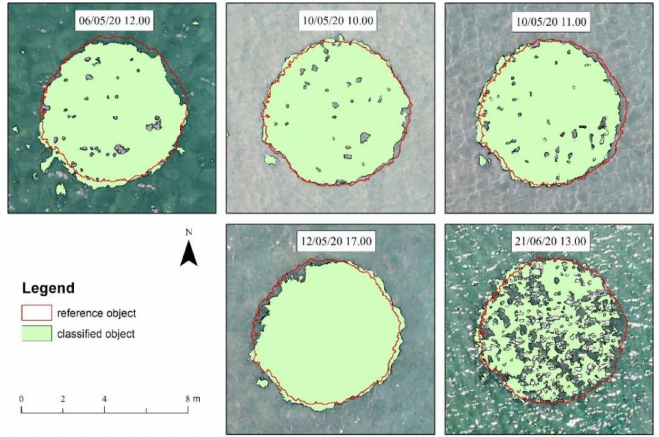
Figure 6. The differences in extent and shape of an object per date in comparison with the reference object presented in the red